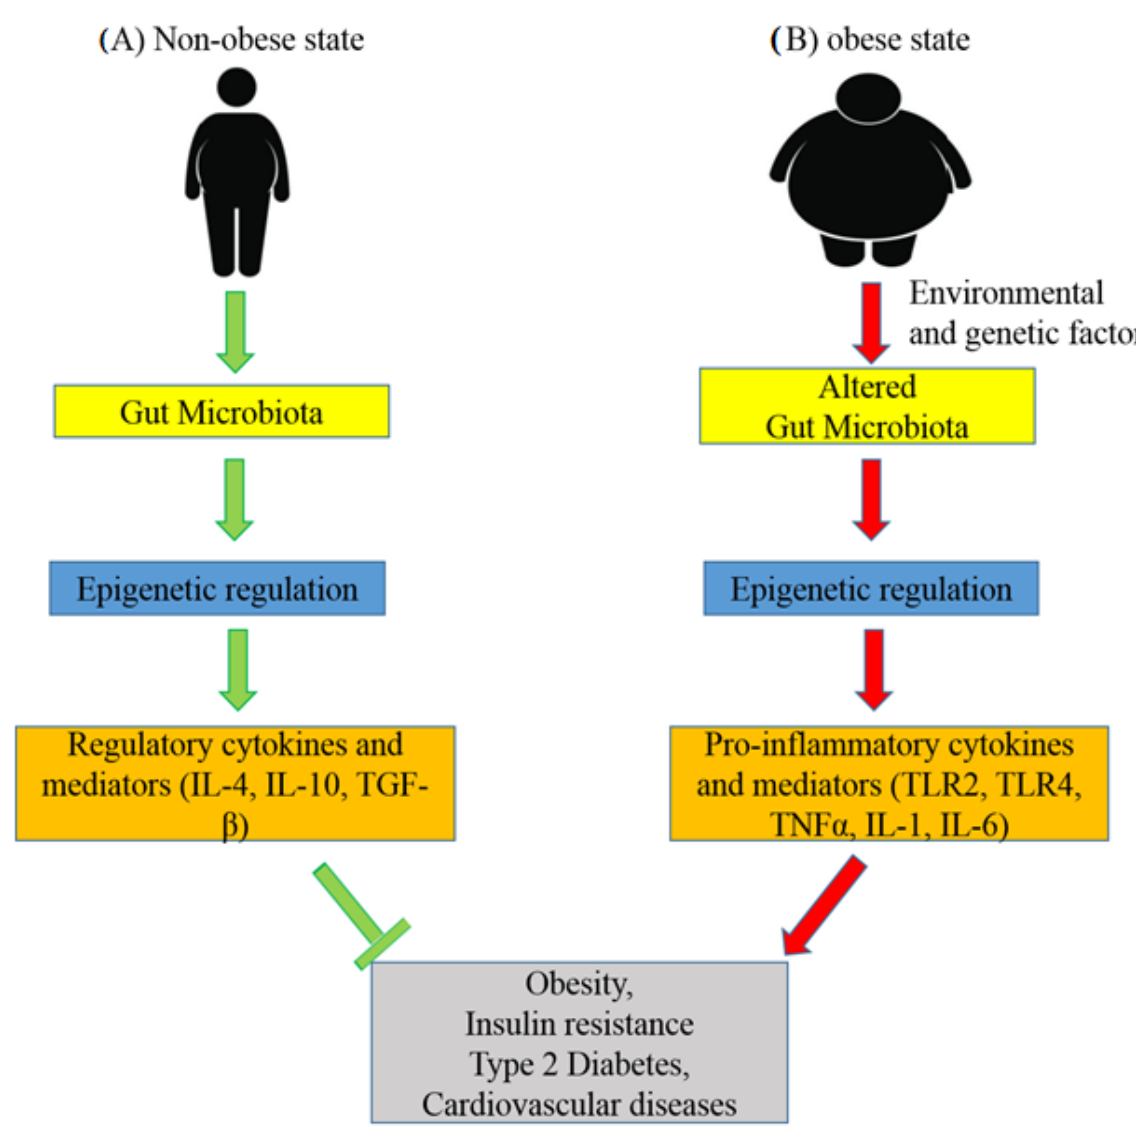
Figure 3. Representative figure of the role of the gut microbiota in epigenetic regulation in non-obese and obese subjects. ( A ) The diversity of the microbiota and its derivatives regulates the stimulation of regulatory cytokines and mediators through epigenetic mechanisms and maintains the healthy balance of the intestinal mucosa. Therefore, the gut microbiota prevents the development of obesity, T2DM, insulin resistance, cardiovascular diseases, and other metabolic diseases. ( B ) Environmental and genetic factors play significant roles in the alteration of the gut microbiota. This increased penetration of impaired gut microbial components induces inflammation through the epigenetic alteration of inflammatory molecules and results in the development of metabolic disorders.